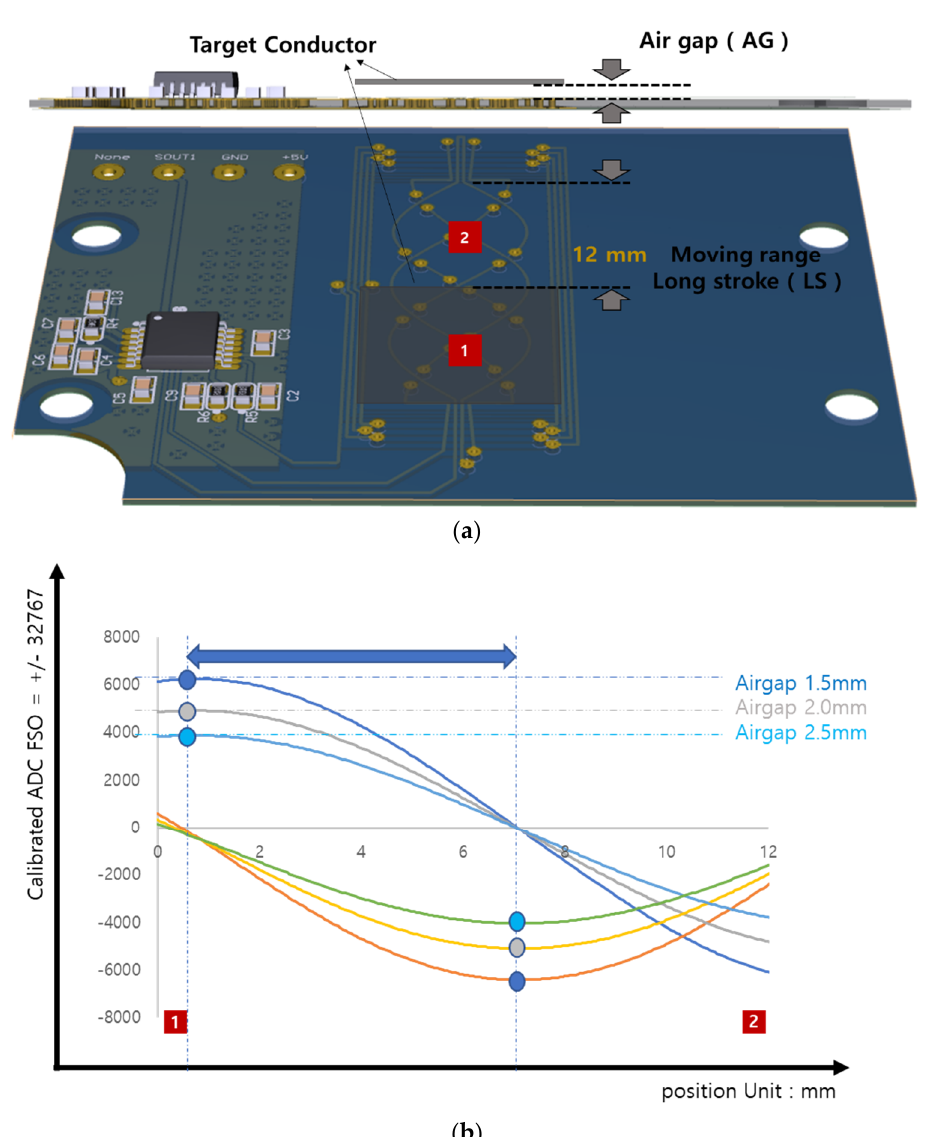
Figure 6. ( a ) Inductive position sensor (IPS)-target moving range (12 mm) on the PCB inductive position. ( b ) IPS raw data for change in analog–digital converter (ADC) amplitude for position range 0–12 mm and various airgaps (1.5, 2, or 2.5 mm), raw phase value of sin θ or cos θ , and the blue arrow is always the same by airgap change.